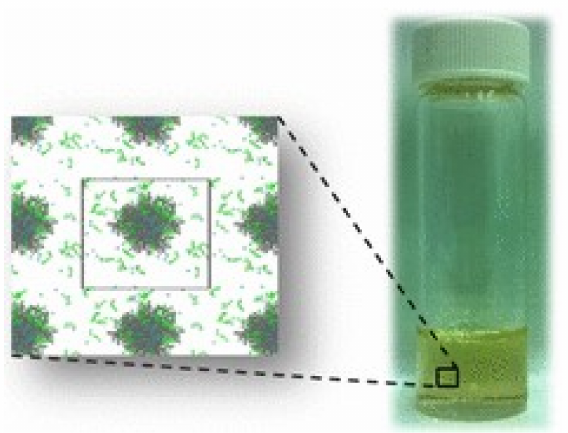
Figure 6. Inverse micelles were prepared in a ( left ) simulation study and ( right ) using the wa- ter/oil microemulsion method. Reprinted with permission from [81]. Copyright 2017 American Chemical